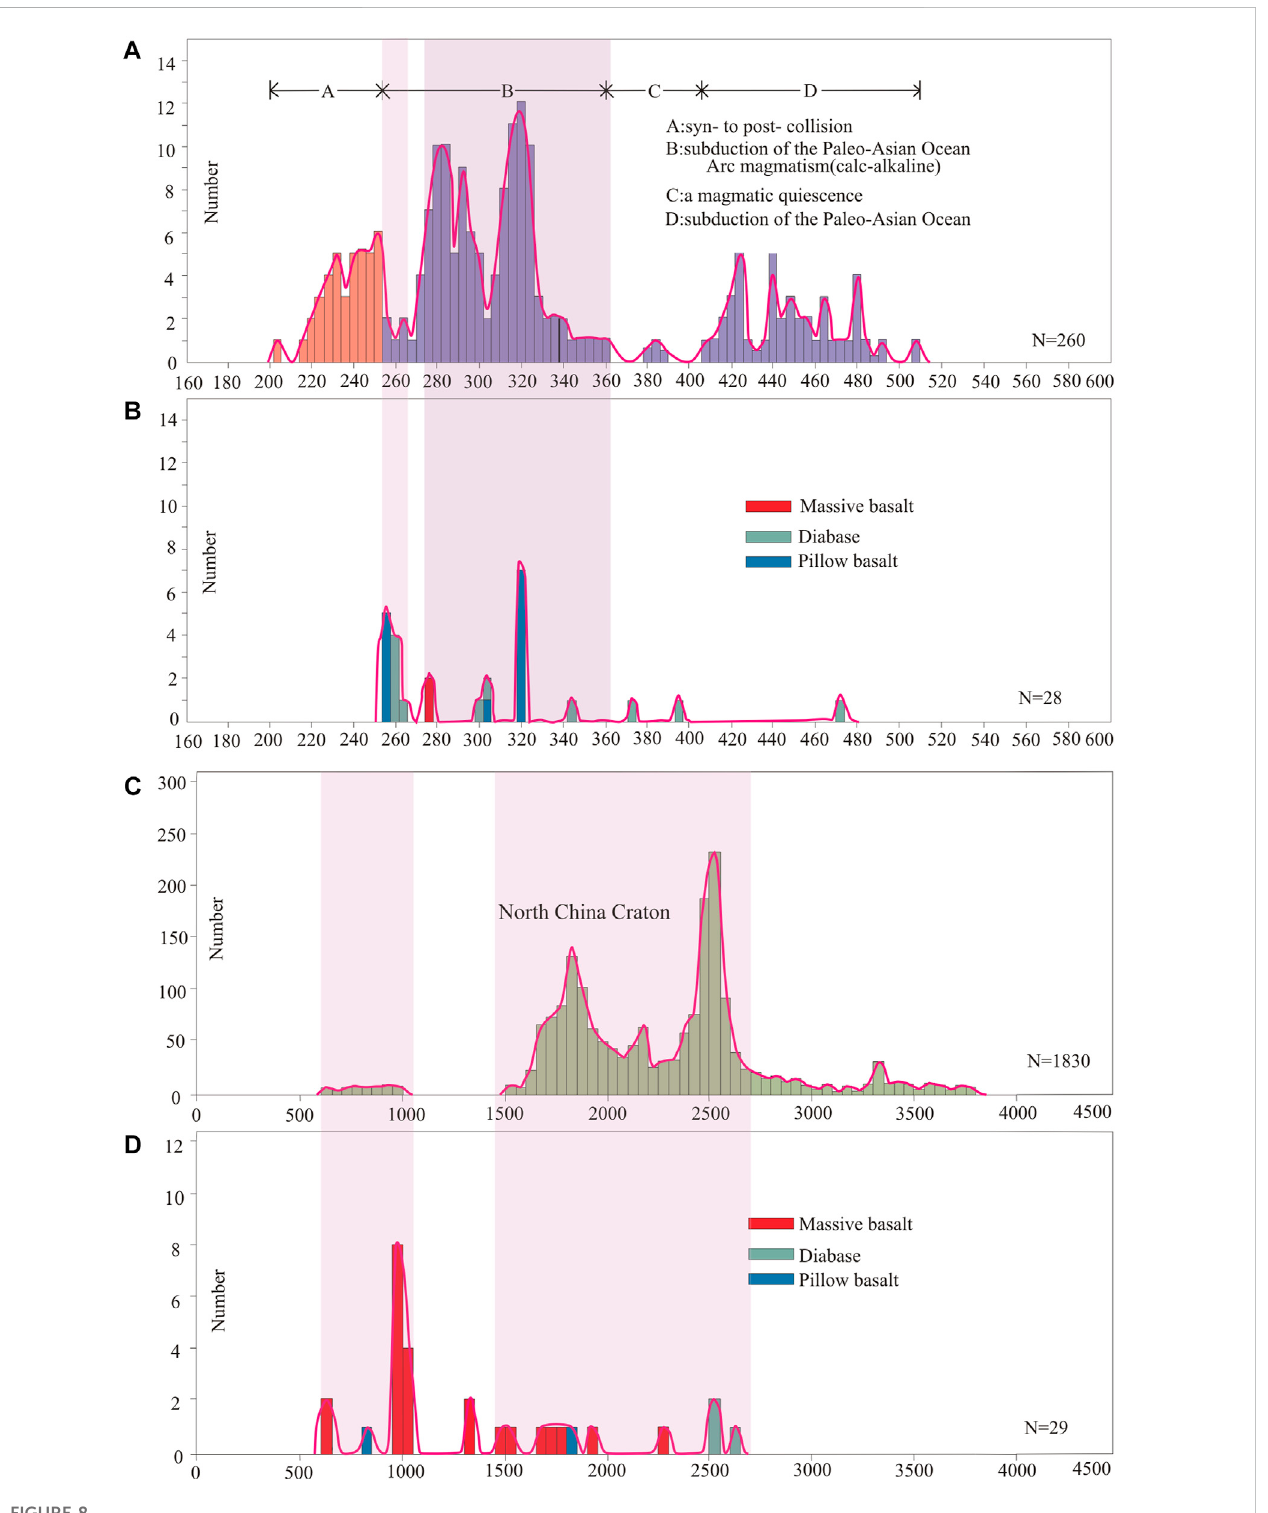
FIGURE 8 (A) Age spectrumsof the adjacent areas (values are from Miao etal., 2008;Song et al., 2015;Lu etal., 2020); (B) Age spectrums ofthe study area; (C) Age spectrums of the North China Craton (after Lu et al., 2020); (D) Age spectrums of the study area.